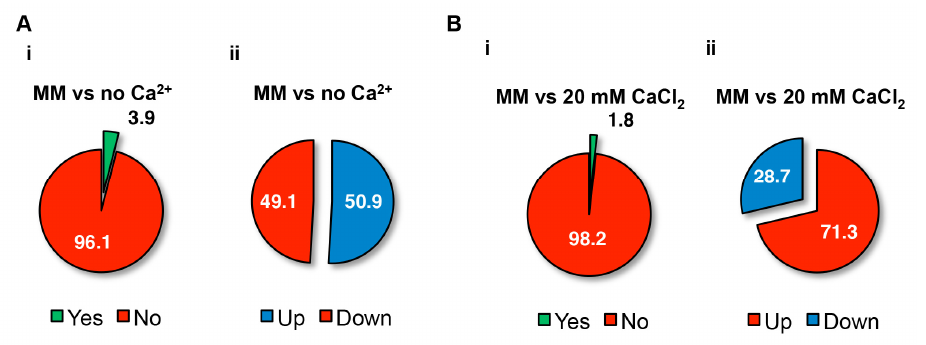
FIGURE 4: Overview of the N.